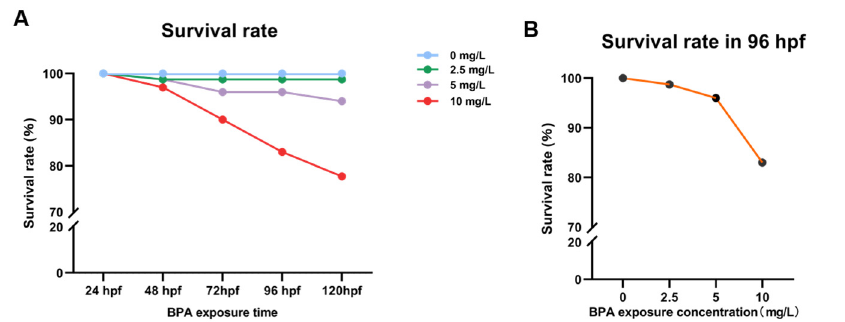
Figure 2. Survival rate of zebrafish exposed to BPA. (A) Survival rate of zebrafish exposed to different concentrations of BPA. (B) Survival rate of zebrafish exposed to different concentrations of BPA at 96hpf. The modified Kohl method was used to calculate the LC 50, 72 hpf = 12.639 mg/L, 95% confidence interval of 11.857–13.473; LC 50, 96 hpf = 10.193 mg/L, 95% confidence interval of 9.040–11.494; LC 50, 120 hpf = 9.045 mg/L, 95% confidence interval of 7.608–10.753. Data are the mean ± SD (n = 90 in each concentration).